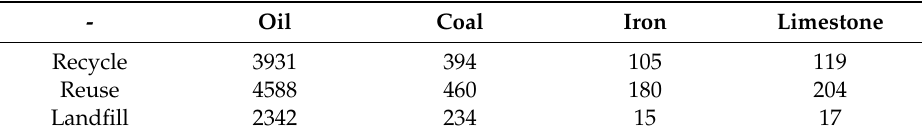
Table 3. The inventory data of construction waste (unit: g /